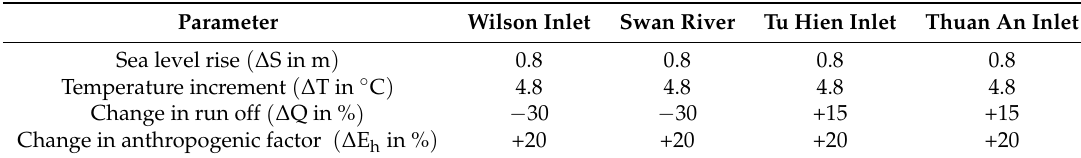
Table 2. Model input parameters for baseline case simulation (year